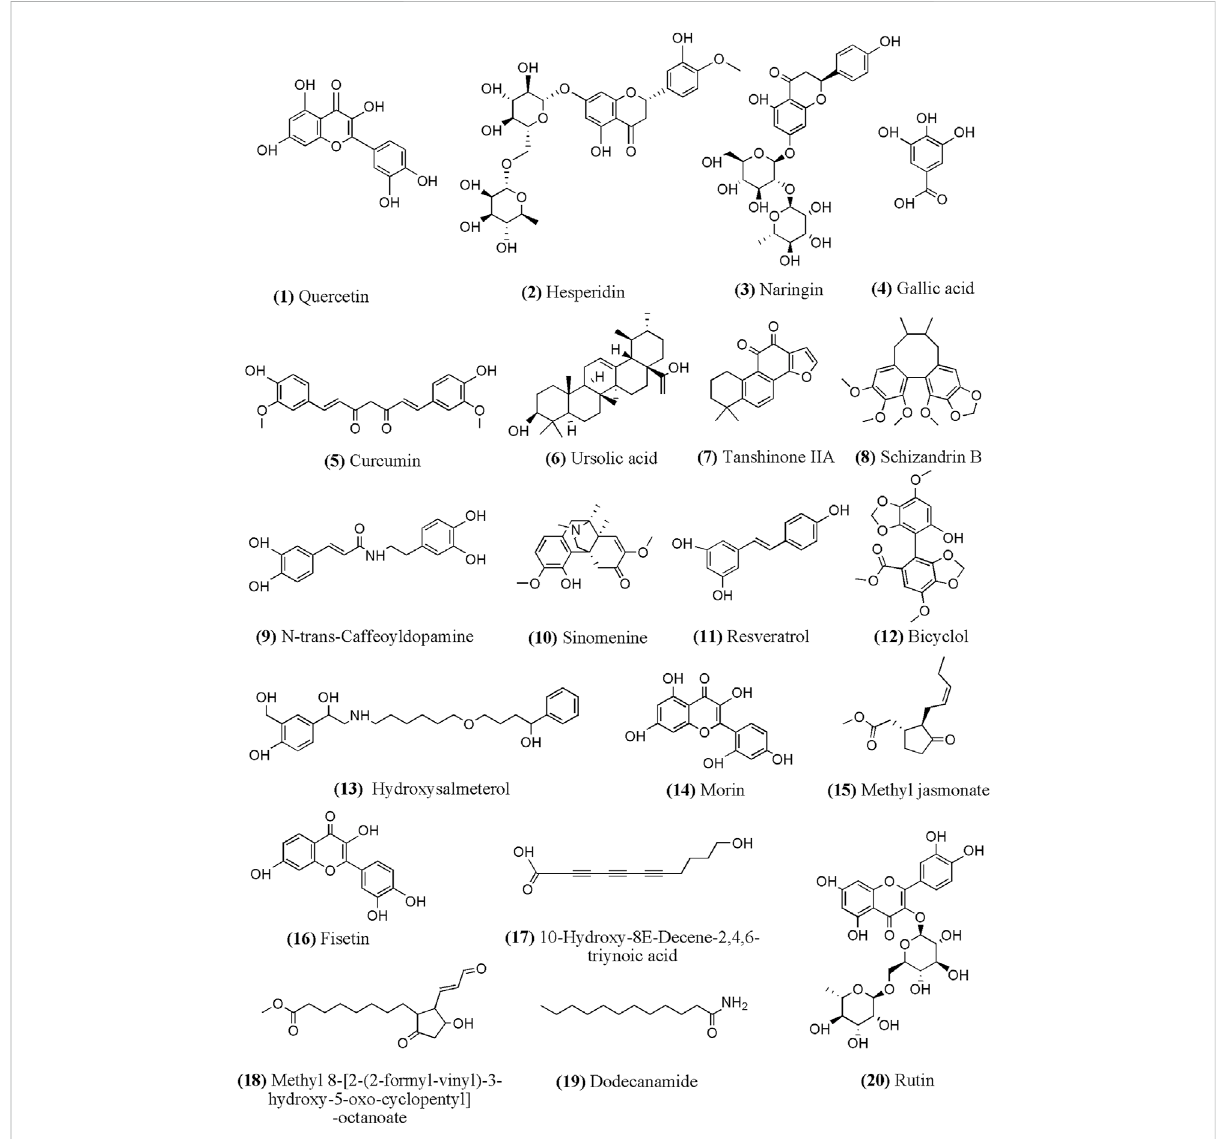
FIGURE 4 Chemical structural of part monomer compounds against INH/RFP-induced liver injury. Notes: (12)-(20) identi fi ed from Crocus sativus L. extract containing polyphenols.